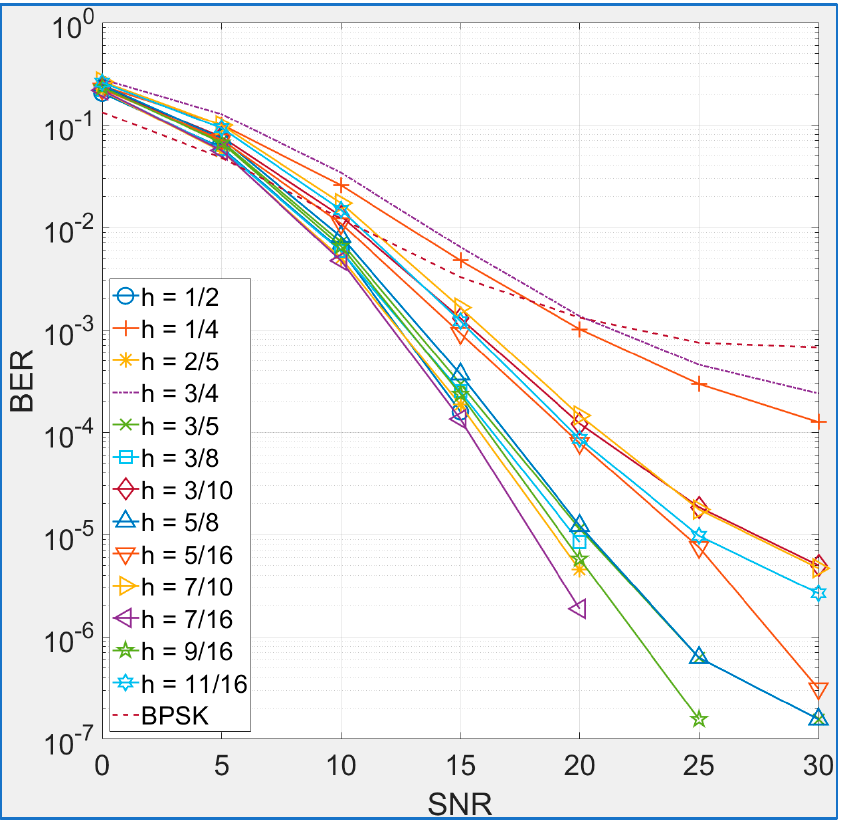
Figure 12. BER performance of binary CPM-GFDM vs. BPSK-GFDM for matched filter receiver over frequency-selective channels. Table 4. Modulation Indices Giving Better Performance Than Conventional